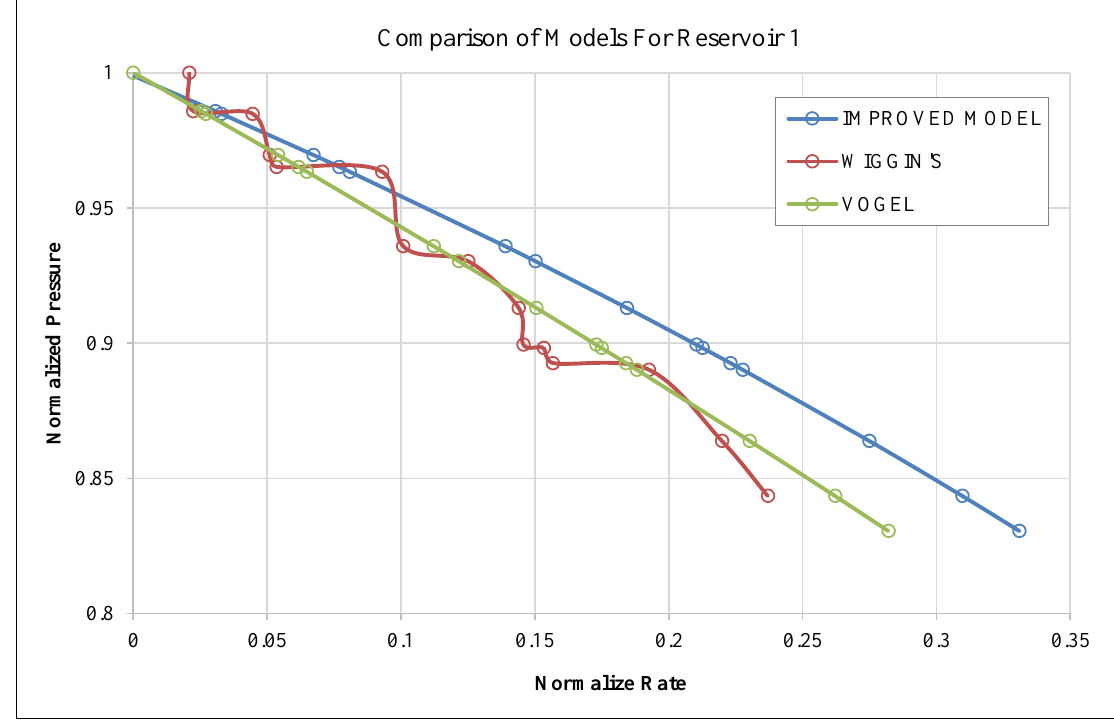
Figure 3. Plot of Normalized Pressure against Normalized Rate for Reservoir